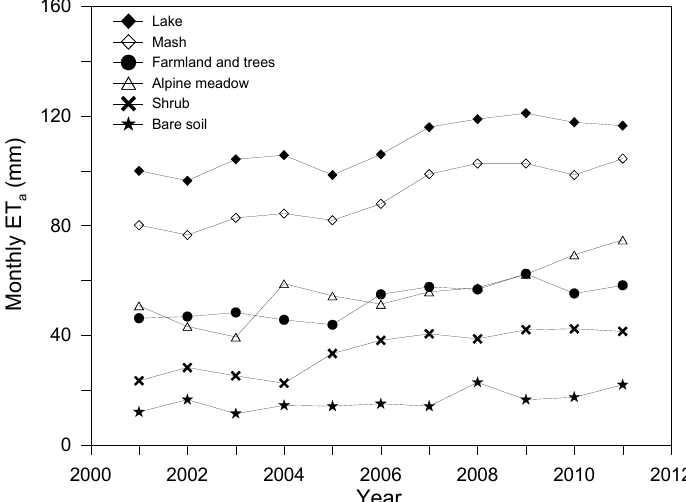
of different land cover types in Qaidam Basin. a